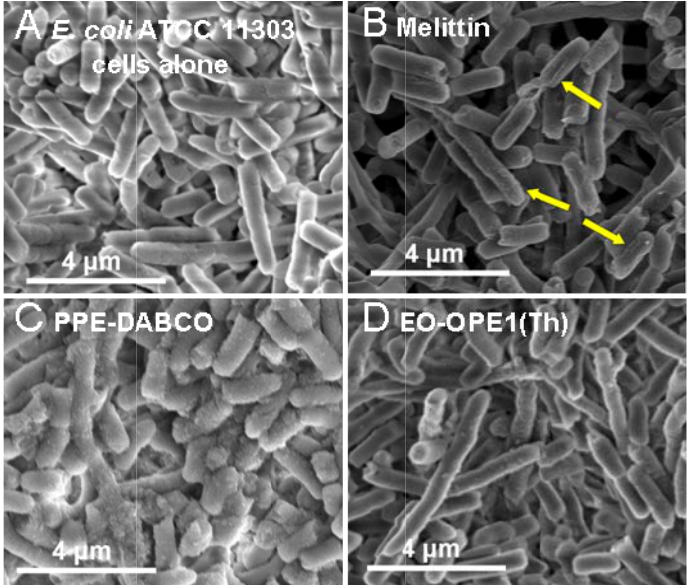
011 , 3 Figure e 3. SEM 10 µg g/mL antimi image s are 4 µm.